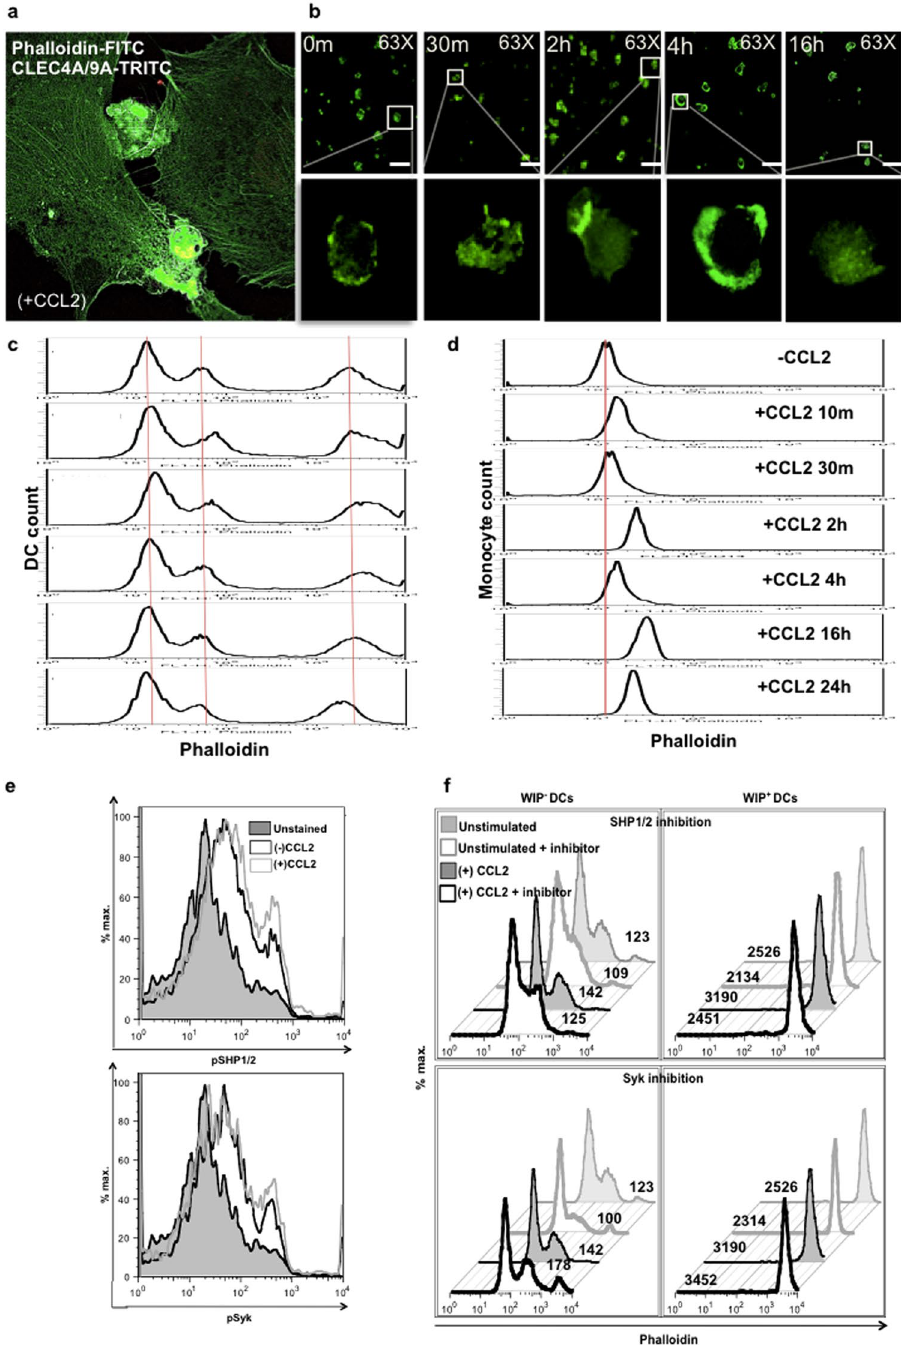
Figure 4. Increased actin polymerization dynamics in DCs upon CCL2 treatment and its decrease upon SHP1/2 inhibition. ( a ) PBMCs were added to a transwell containing a confluent layer of activated hCMEC/ D3 cells in the insert and CCL2 (100 ng/ml) in the lower well. After 2 h, transwell was stained for phalloidin- FITC (3 ug) as well as TRITC labeled anti-CLEC4A, -CLEC9A antibodies. Microscopy evidence of intense F-actin expression on cells (co-labeled as yellow) as they appear to be transmigrating between two endothelial cells (green). Images are representative of several fields of vision taken on three separate transwells. ( b ) Confocal microscopy images indicate areas of actin polymerization on MDDCs treated with CCL2 (100 ng/ ml) for indicated durations and labeled with phalloidin-FITC. All images were taken at 63X. Scale bar: 25 μ m. Flow cytometry histograms show staining intensity of ( c ) MDDCs and ( d ) monocytes at different time points indicating more (right shift) or less (left shift) addition of actin subunits in reference to the control (red line). ( e ) Identification of SHP1/2 and Syk phosphorylation in MDDCs upon CCL2 treatment. ( f ) Phalloidin-FITC histograms on WIP − and WIP + MDDCs upon SHP1/2 inhibition (30 uM) for 3 h or Syk inhibitor (piceatannol, 30 uM) for 1 h. Histograms are representative of results from two individual donors. (See also Figure